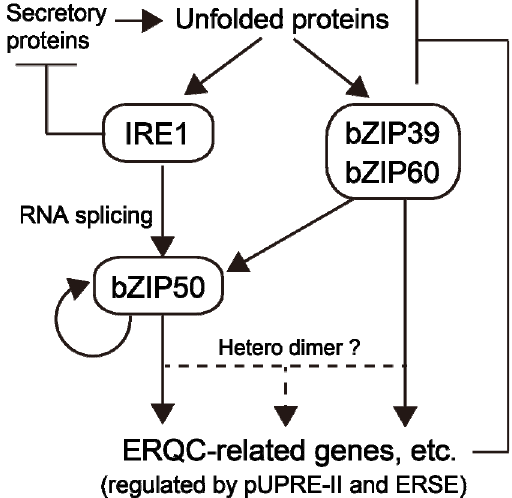
Figure 3. Model of the relationship between ER stress sensors and OsbZIP50. A large amount of secretory proteins increases unfolded proteins in the ER lumen. The accumulation of unfolded proteins induces active forms of the ER stress sensors OsIRE1, OsbZIP39 and OsbZIP60. Proteolytically activated OsbZIP39 and OsbZIP60 induce the expression of ER quality control (ERQC)-related genes and OsbZIP50 . OsbZIP50, activated by OsIRE1-mediated mRNA splicing, induces its own expression and the expression of ERQC-related genes. Some OsbZIP50 and OsbZIP39 or OsbZIP60 form heterodimers. The inducibility of gene expression by these transcription factors is regulated by cis -elements, such as pUPRE-II and ERSE. ERQC-related gene products contribute to the reduction in unfolded proteins and the end of strong UPR. In addition to the activation of OsbZIP50 mRNA, OsIRE1 suppresses a certain type of secretory protein and, thereby, avoids worsening ER